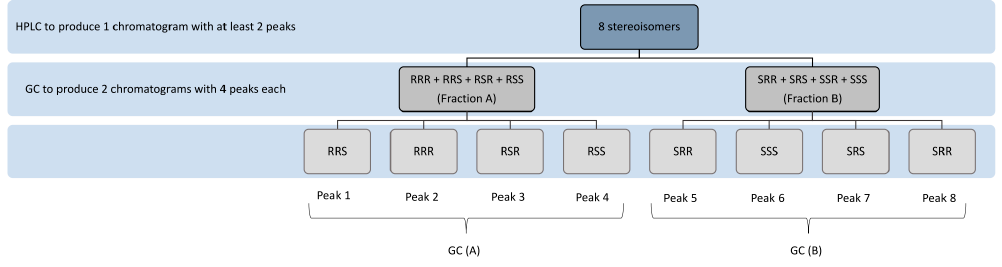
Figure 5. Schematic flow of the separation process for the eight stereoisomers.